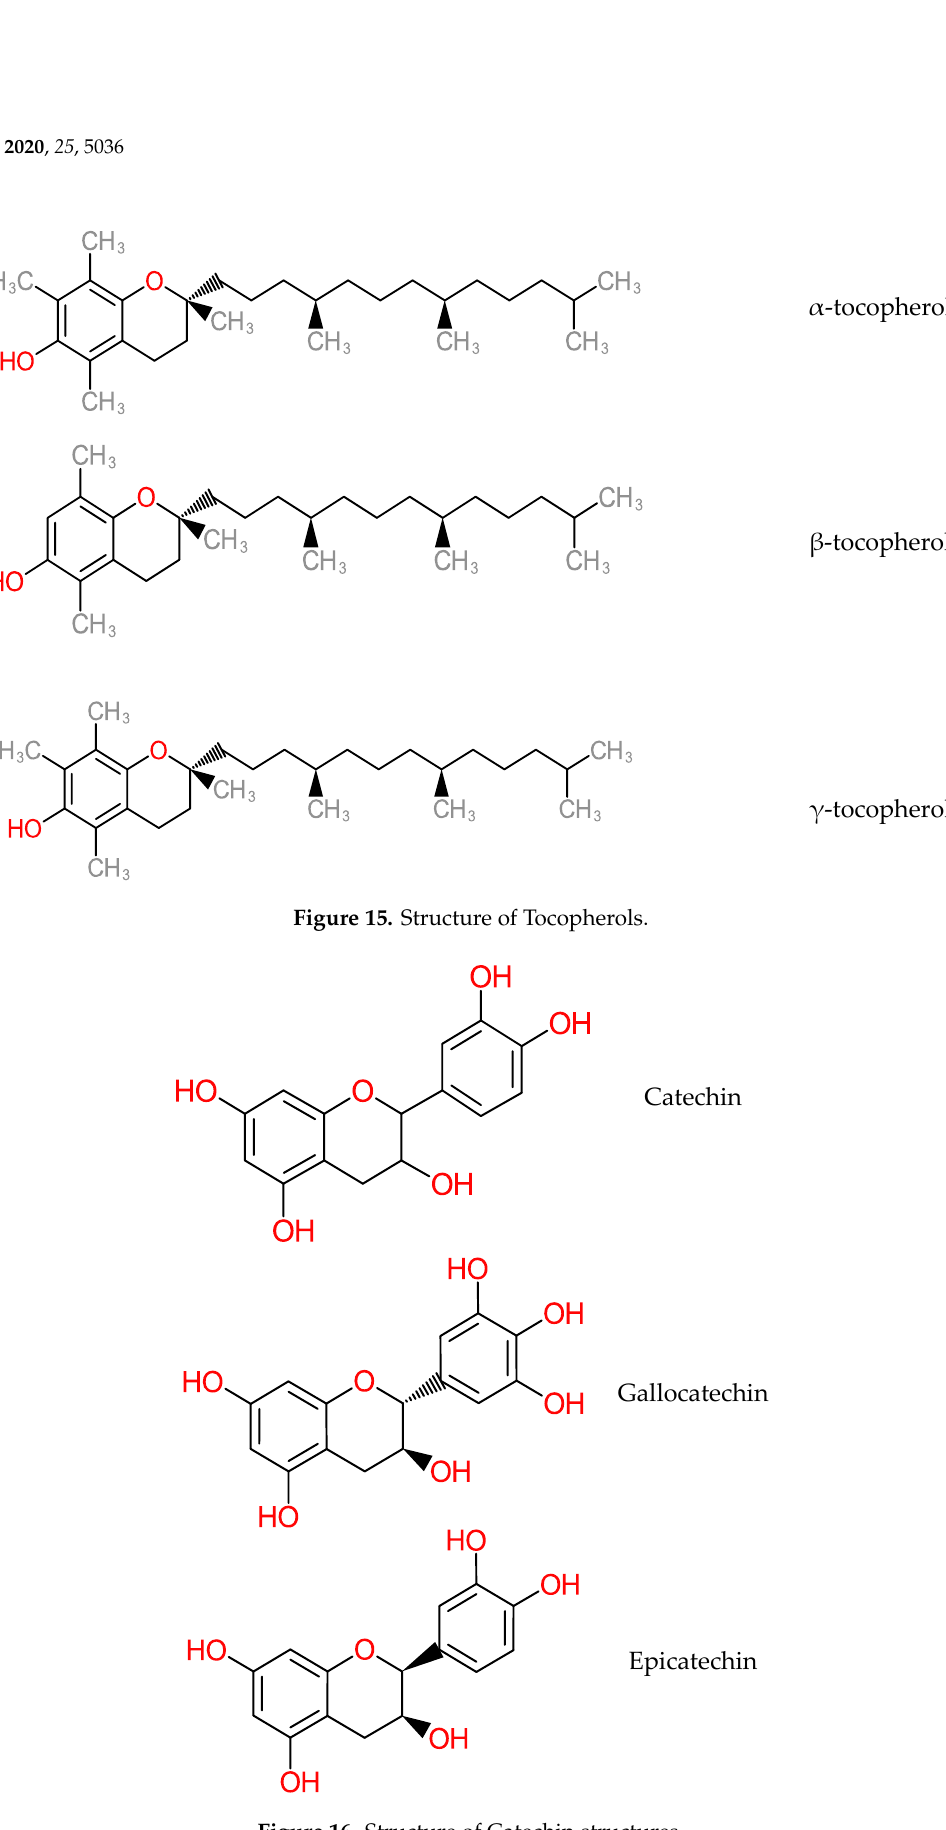
Figure 16. Structure of Catechin structures.